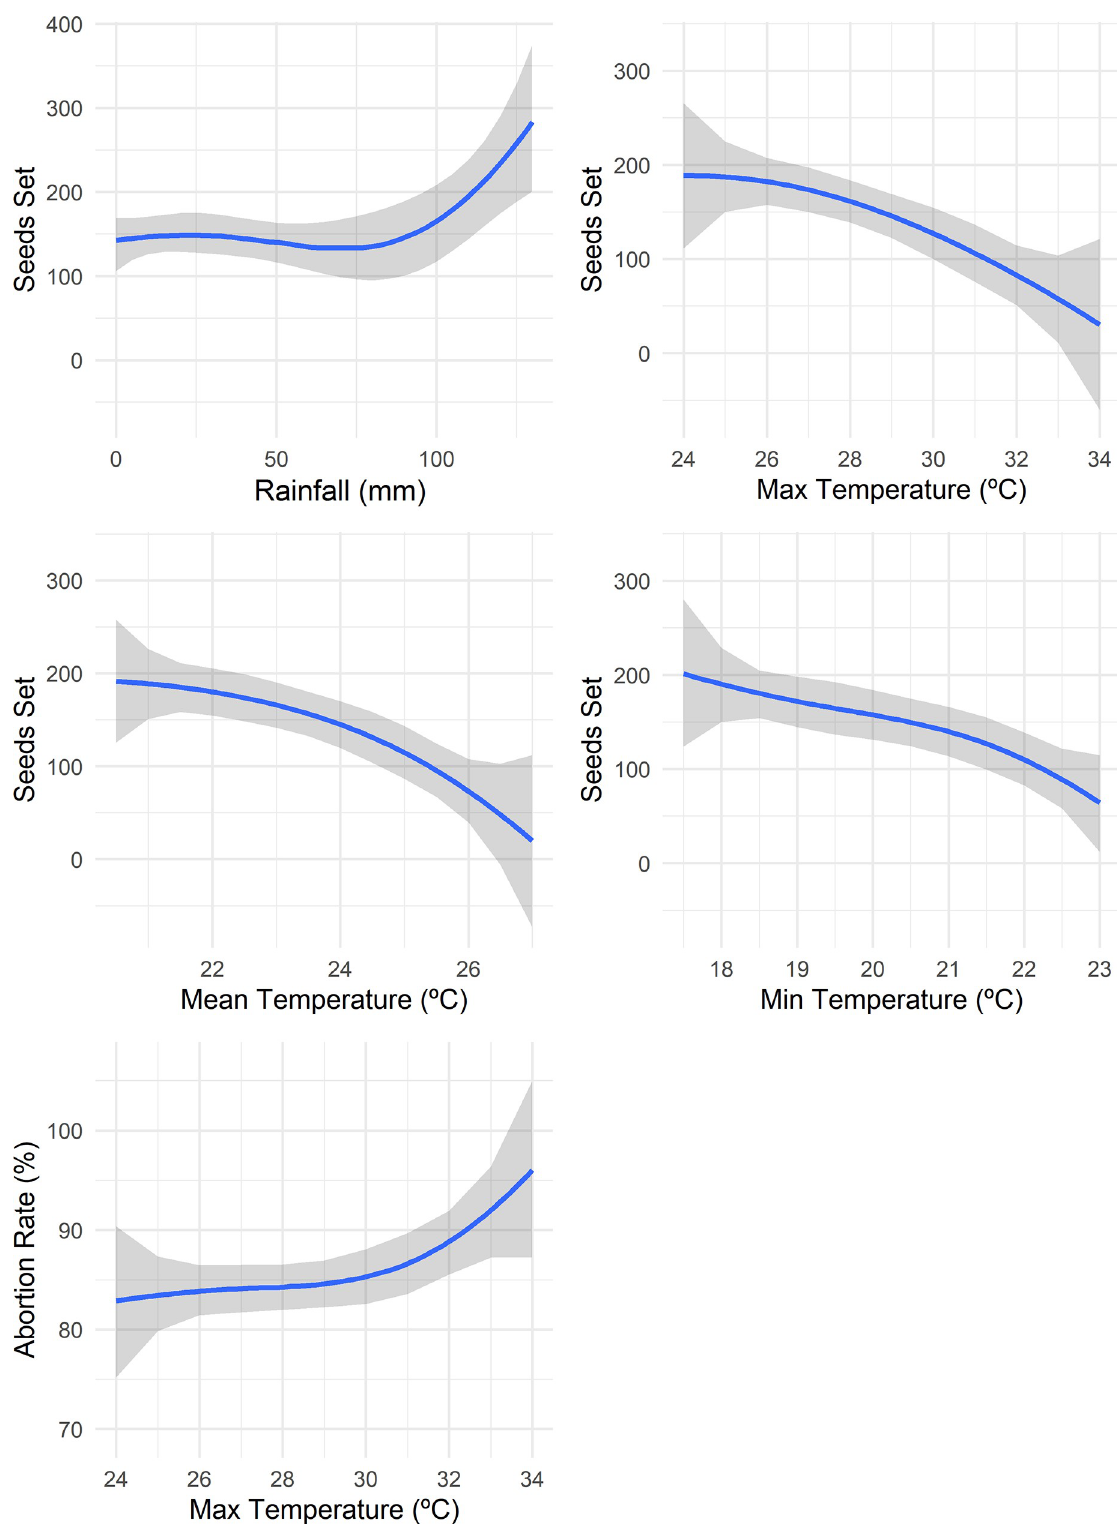
Fig 1. Cubic regression of weather variables (rainfall and minimum, average, and maximum temperatures) for the seed setting rate (seeds produced every hundred crossings) and maximum temperature for abortion rate. The blue line is the cubic regression line, while the gray area refers to the confidence interval of the